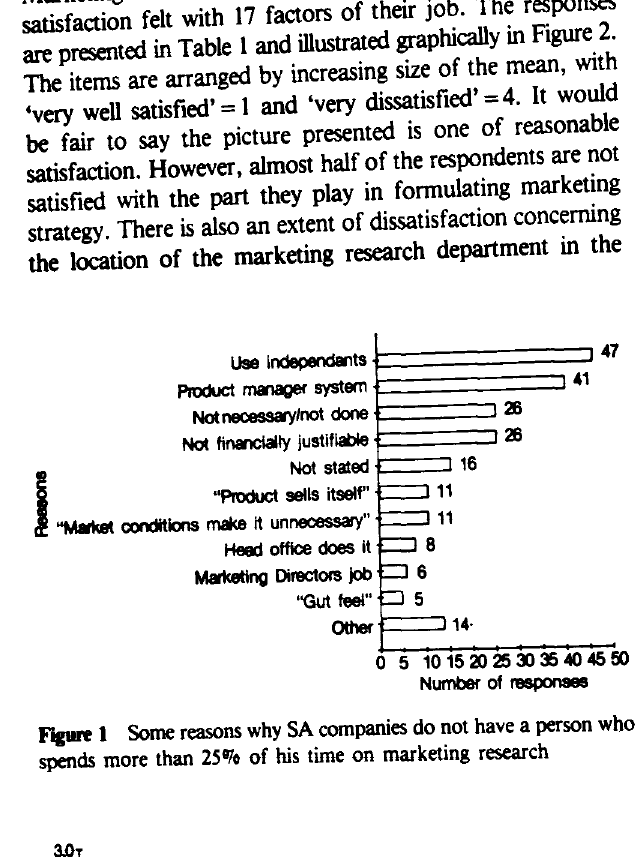
Figure 3 The marketing executive - satisfaction with the